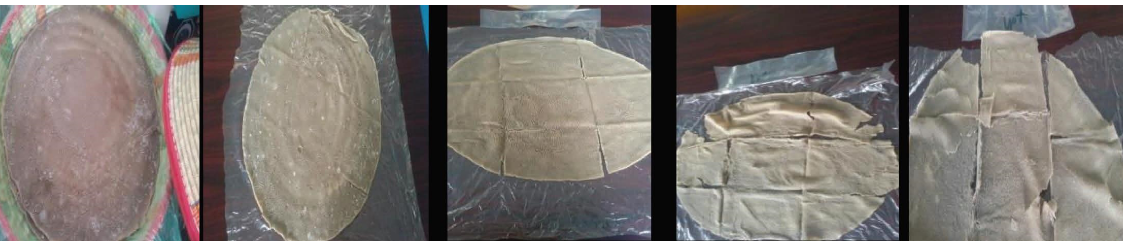
Figure 6: Pictures of injera samples (C at 6 th day, NP at 9 th day, NP+, VP and VP+ at 15 th day,